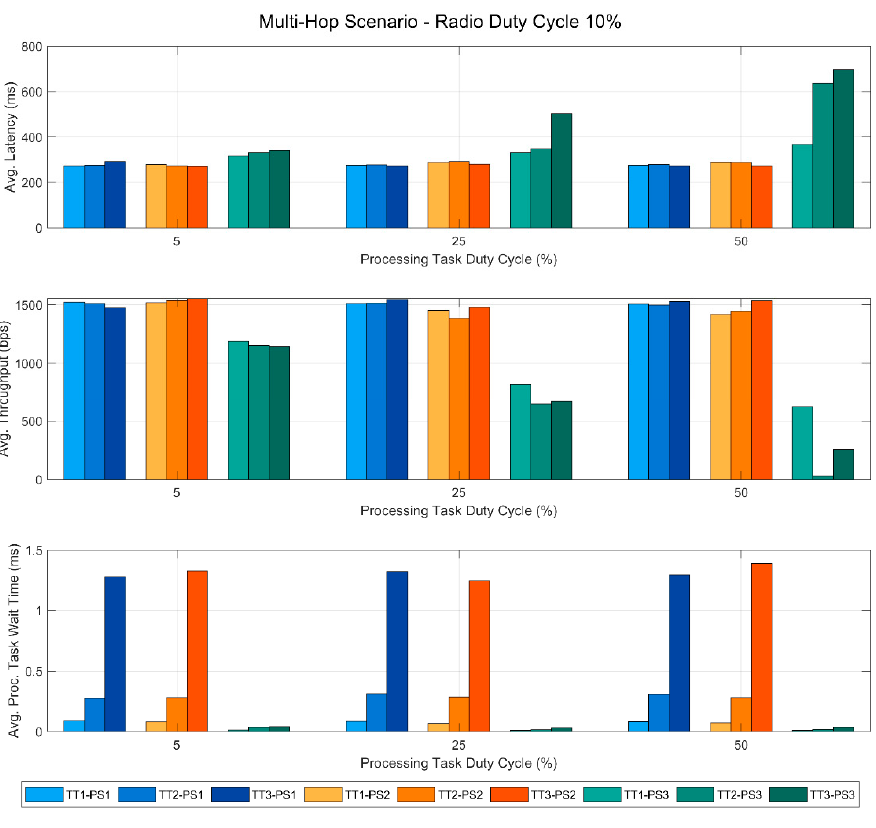
Figure 7. Multi-hop scenario with a fixed RDC of 10%.